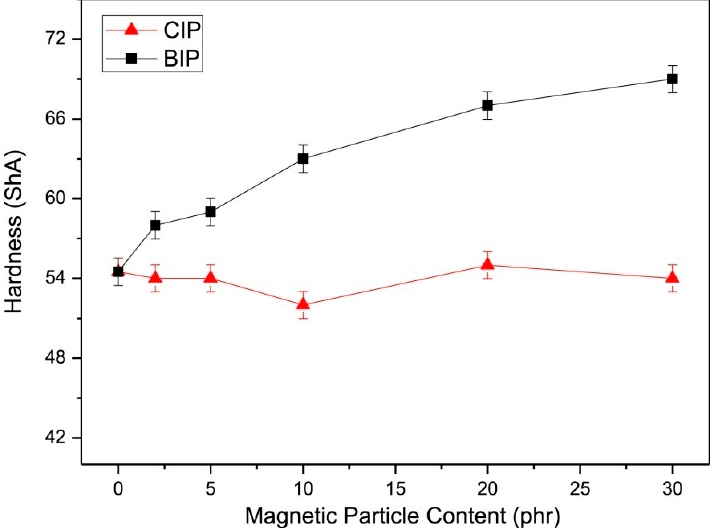
Figure 7. The plot of shore A hardness as a function of magnetic particle content (phr) of EPDM-based MREs containing BIPs and CIPs [24] (reprinted with permission from Elsevier TM ).